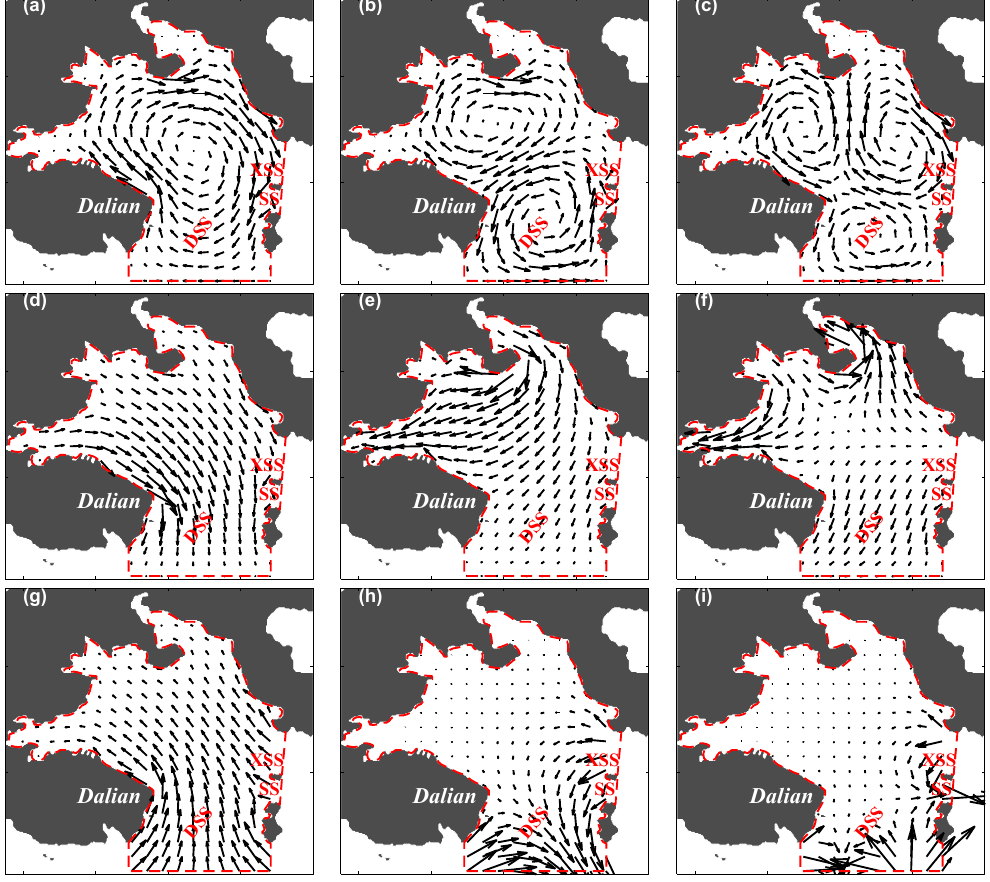
Figure 2. Distributions of the first three modes in the model domain: The first row ( a – c ) indicates the Dirichlet modes ψ 1 , ψ 2 , and ψ 3 , the second row ( d – f ) indicates the Neumann modes φ 1 , φ 2 , and φ 3 , and the third row ( g – i ) indicates the open-boundary modes φ b and